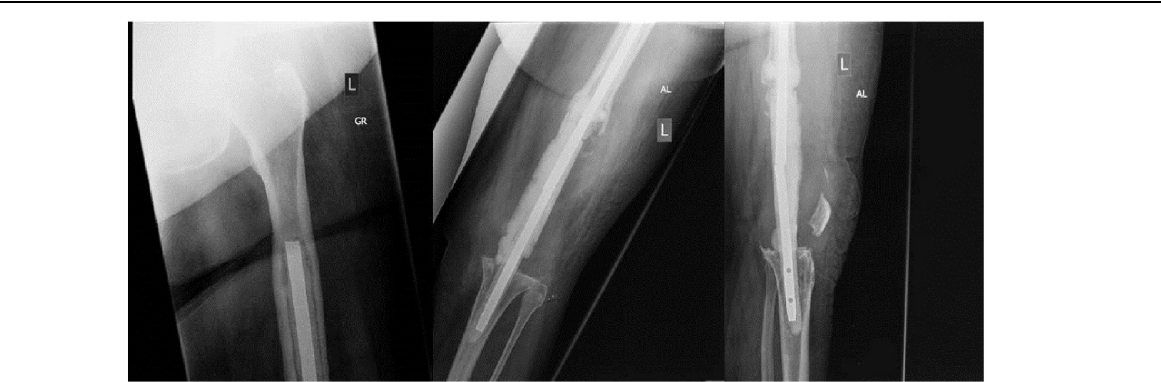
Figure 5: X-rays of the left knee of a 52-year female patient showing a septic loosening of the femoral component two years after implantation of a tumor prosthesis.